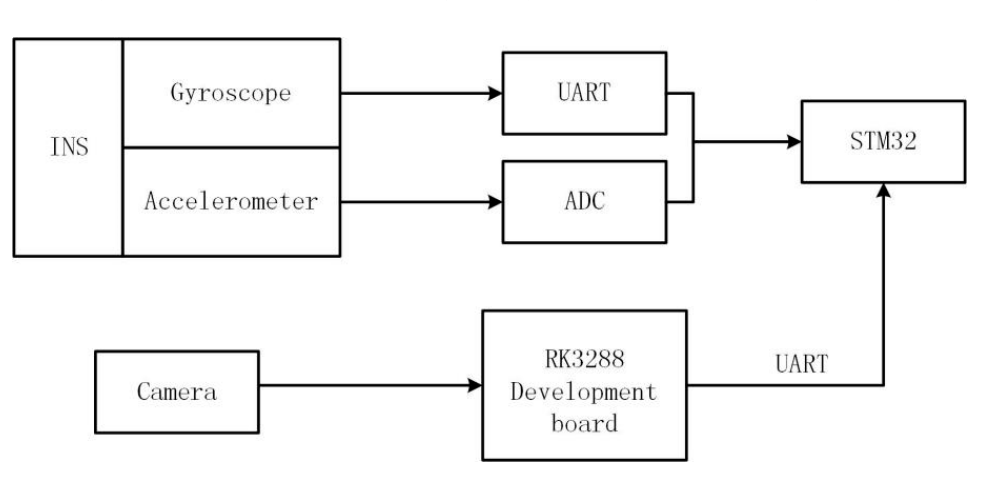
Figure 5. Brain-like navigation system. UART: Universal Asynchronous Receiver/Transmitter; ADC: analog-to-digital